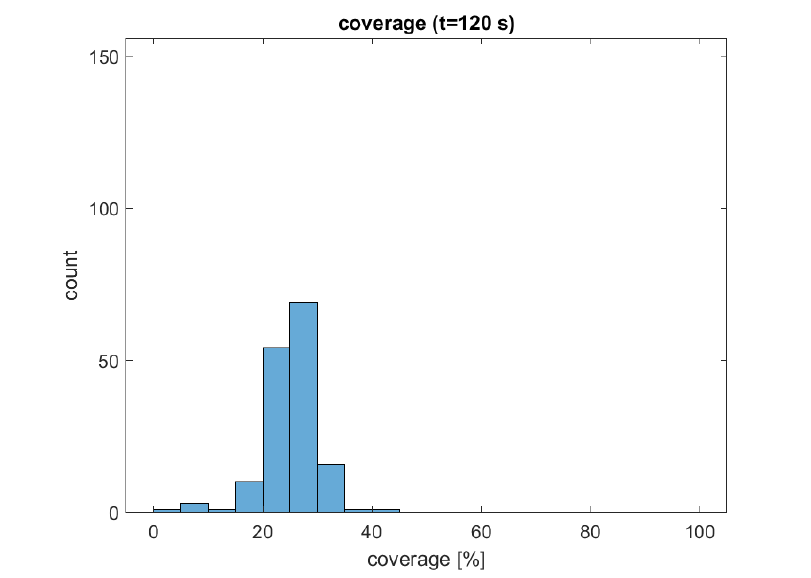
Figure 9. Distribution of coverage at 120 s of scenario